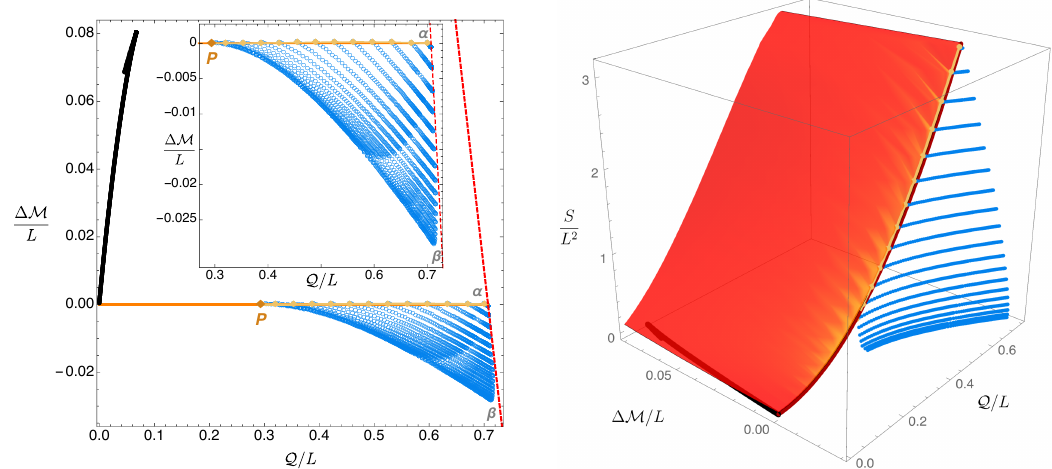
Figure 3 . Phase diagrams for Einstein-Maxwell theory with a scalar field charge e = 1 ( e ≤ NH e < e γ ) in a Minkowski box. Left panel: quasilocal mass difference ∆ M /L as a function of the quasilocal charge Q /L . The black disk curve is the main/perturbative soliton family, the orange line is the extremal RN BH (RN black holes exist above it), and the blue circles describe hairy black holes. The yellow curve is the superradiant onset curve of RN (just above but very close to the extremal RN curve with the two merging at P and α ). It agrees with the hairy solutions in the limit where these have (cid:15) = 0 (no scalar condensate) and thus merge with RN family. The √ red dashed line with negative slope signals solutions with ∆ M /L = 1 − 2 Q /L i.e. black holes with horizon radius R = 1 (above this value they do not fit inside the cavity). Right panel: + dimensionless entropy S/L 2 as a function of the quasilocal charge and mass difference. RN BHs are the two parameter red surface with extremality described by the 1-parameter curve ∆ M = 0 (dark red). The instability onset is described by the yellow curve (very close to extremality) and RN between these two curves are unstable. When they coexist with RN BHs, for a given ( Q , M ) /L , hairy BHs (blue dots) always have more entropy than RN, i.e. they dominate the microcanonical ensemble. For e ≤ e < e γ , hairy BHs terminate at an extremal BH ( i.e. with zero temperature) NH and finite entropy (and divergent horizon curvature). The soliton (black dots) with zero entropy is also